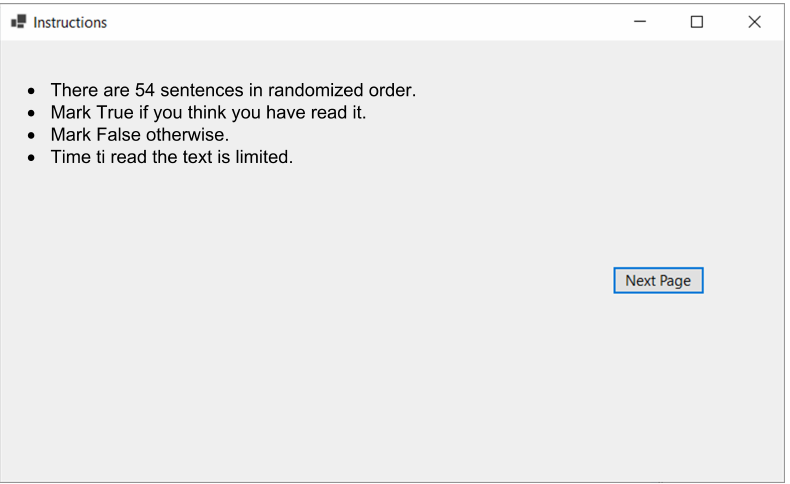
Figure 4. Instruction